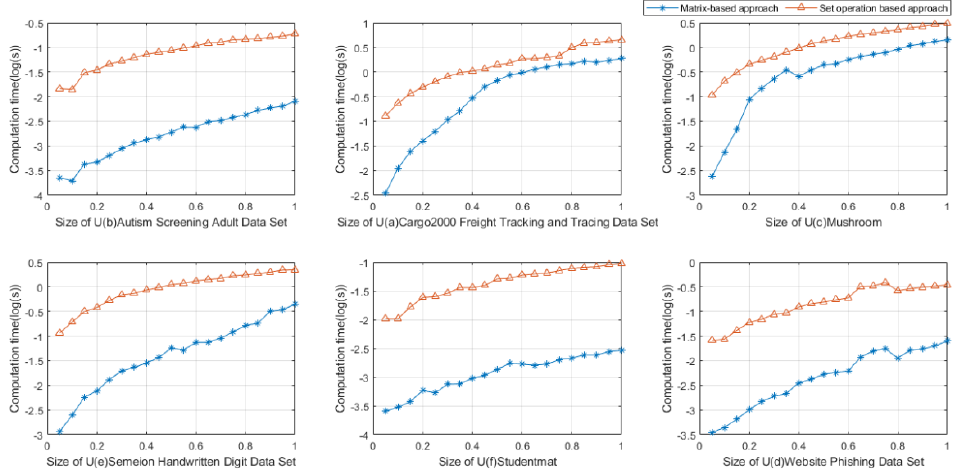
Figure 1. Comparison of the time of matrix-based approach and set-operation-based approach.